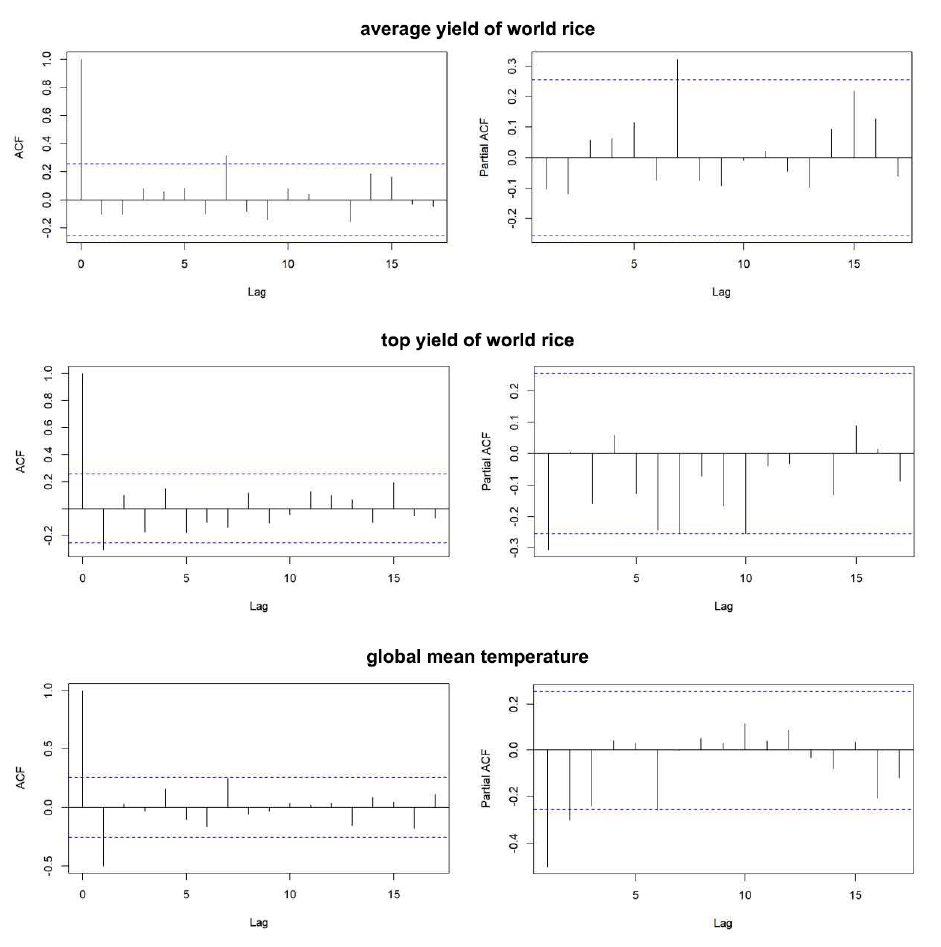
Figure 2. Test results of series’ ACF and PACF for average and top yields of world rice and global mean temperature from 1961 to 2020.